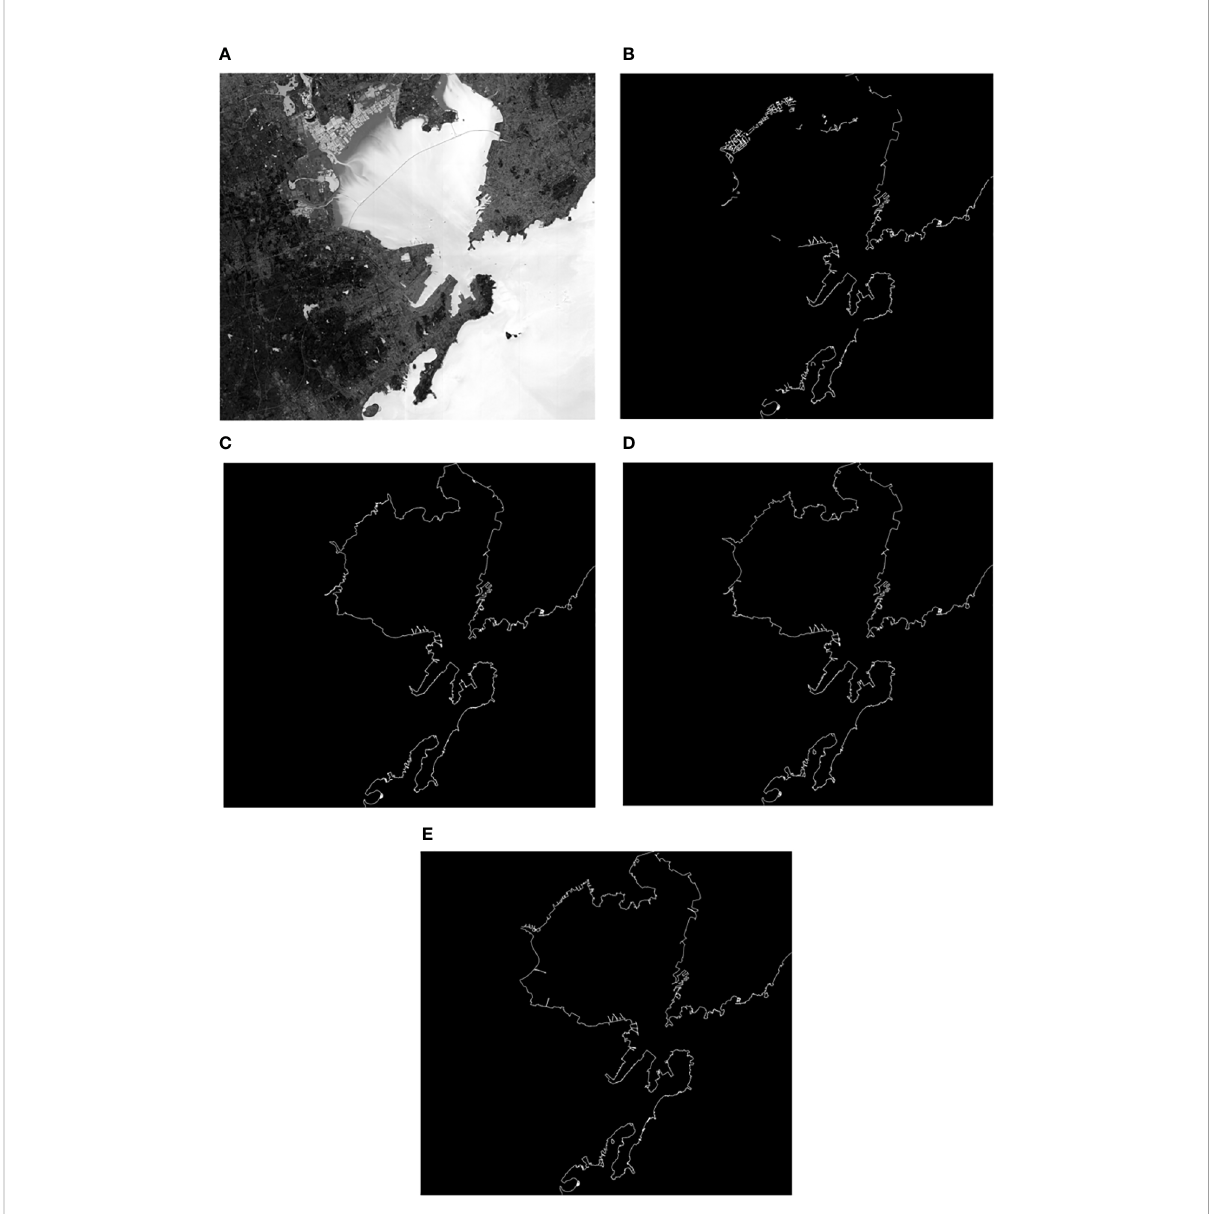
FIGURE 9 Extraction results of Jiaozhou Bay: (A) the original image, (B) canny edge detection coastline, (C) the regional growth extracted coastline, (D) OBRGIE extracted coastline, and (E) our method extracted